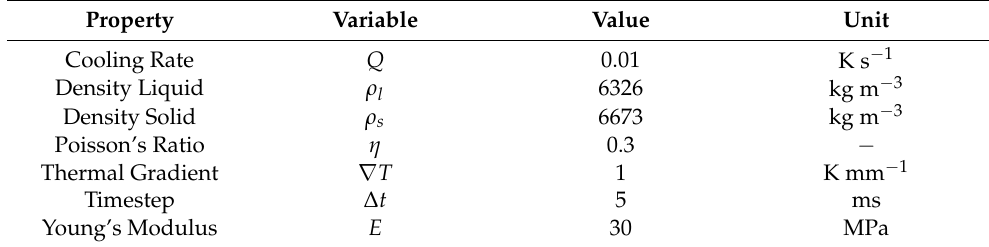
Table 1. Material properties and problem setup values used for simulations. Property Variable Value